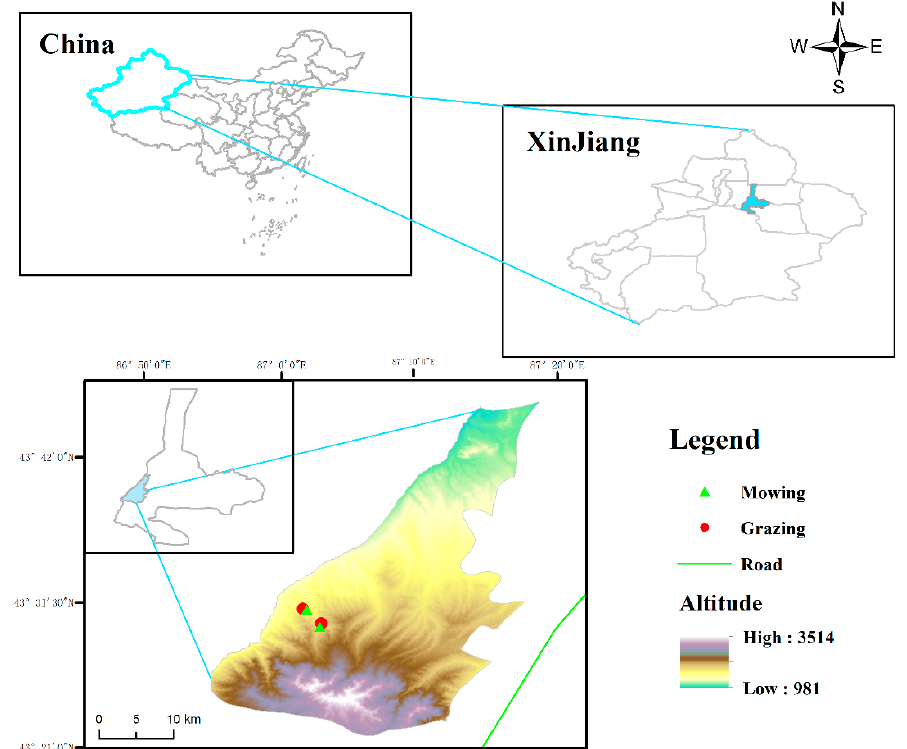
Figure 5. Location of the study area. The low altitude + mowing (87°01 ′ 49 ″ E, 43°30 ′ 58 ″ N; 1631 m asl), low altitude + grazing (87°01 ′ 32 ″ E, 43°31 ′ 02 ″ N; 1612 m asl), high altitude + mowing (87°02 ′ 47 ″ E, 43°29 ′ 44 ″ N; 1809 m asl), high altitude + grazing (87°02 ′ 53 ″ E, 43°29 ′ 59 ″ N; 1804 m asl).